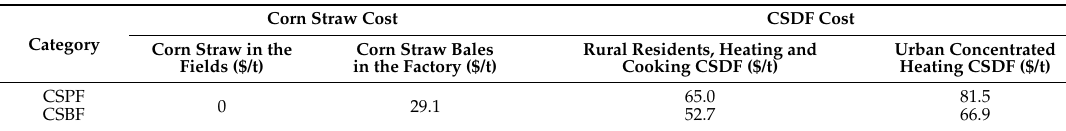
Table 10. Cost of corn straw and CSDF in the CPS.